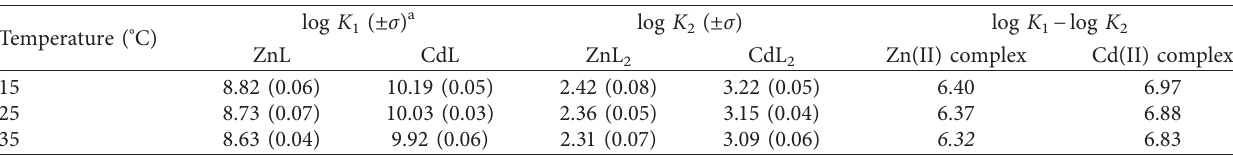
2 O (V/V) solution